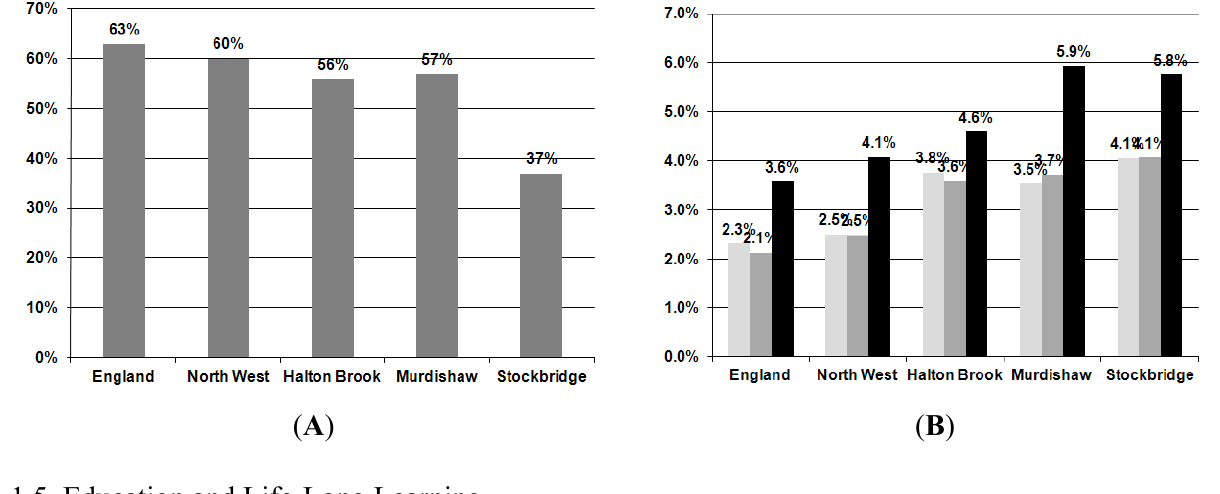
Figure 2. Economic well-being. ( A ) Employment rate of people aged 16–64 (males); 16–59 (females); ( B ) Percentage of economically active people aged 16–64 (males) and 16–59 (females) who claimed jobseeker’s allowance in 2003, 2007 and 2010.